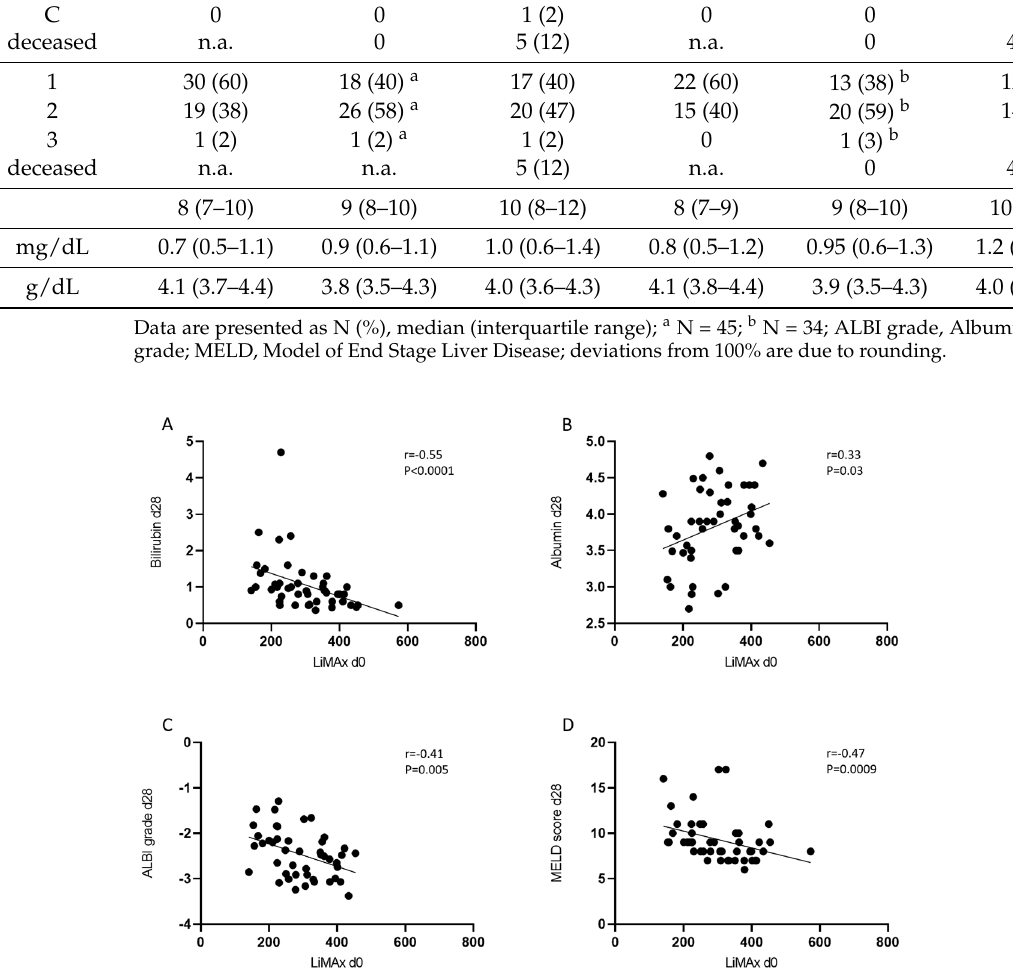
Figure 2. Correlation analysis of LiMAx ® at baseline with liver function 28 days after RE in the whole cohort. ( A ) bilirubin r = − 0.55, p < 0.0001; ( B ) albumin r = 0.33, p = 0.03; ( C ) ALBI grade r = − 0.41, p = 0.005; ( D ) MELD score r = − 0.47, p =